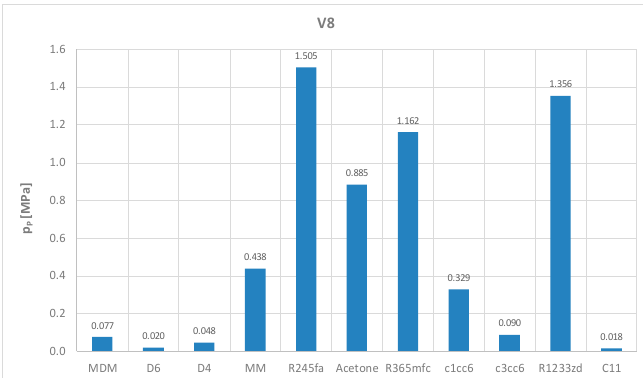
Figure 11. Variant 8—pressure of interstage superheater.